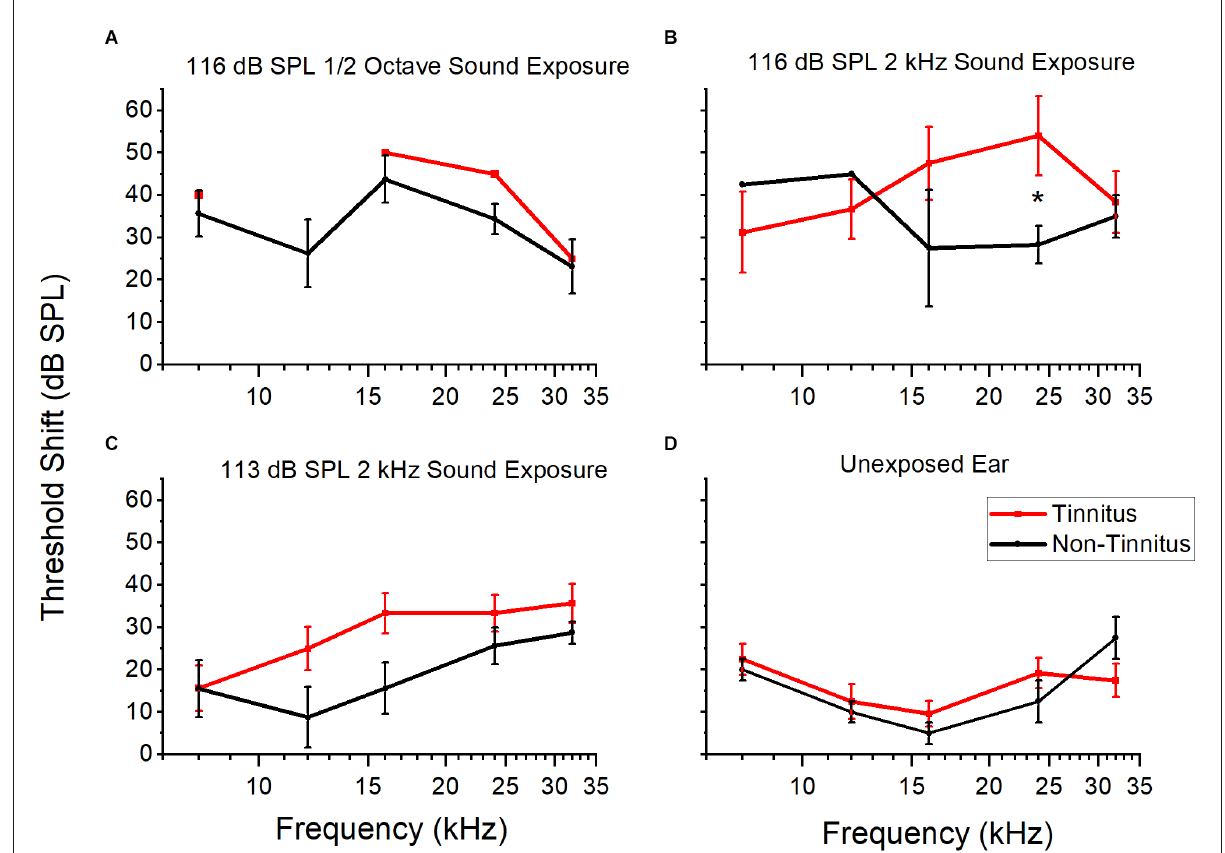
FIGURE5 Threshold shifts of tinnitus and non-tinnitus groups after different sound overexposures. The mean and standard error for threshold shifts at five frequencies (kHz) approximately 2 weeks POST sound exposed for three different sound overexposure paradigms for tinnitus and non-tinnitus animals. (A) Threshold shifts after 116 dB SPL 1 2 octave sound exposure in the exposed ear. Tinnitus n = 1, non-tinnitus n = 4. (B) Threshold shifts after 116 dB SPL 2 kHz sound exposure in the exposed ear. Significance at 24 kHz ( p = 0.04, students two sample t -test). Tinnitus n = 6, non-tinnitus n = 3. (C) Threshold shifts after 113 dB SPL 2 kHz sound exposure in the exposed ear. No significant difference. Tinnitus n = 15, non-tinnitus = 8. (D) Threshold shift for unexposed, right ear across all sound exposures. No significant difference. Tinnitus n = 5, non-tinnitus n = 2. Tinnitus in red, non-tinnitus in black. Data shown as mean and standard error. The lack of standard error bars indicate only one data point for that frequency. * P <